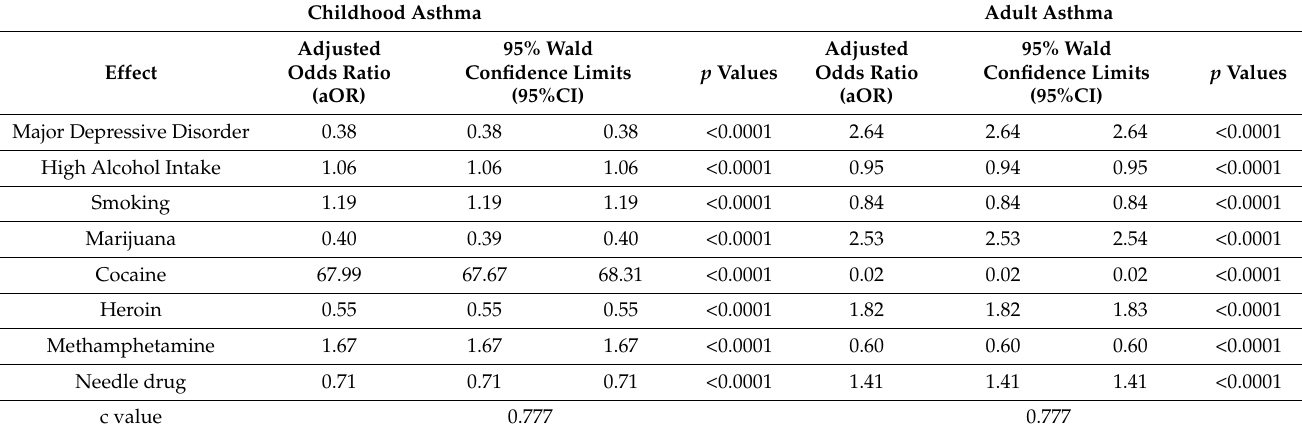
Table 3. Predictors of major depressive disorder and substance use in childhood and adult- onset